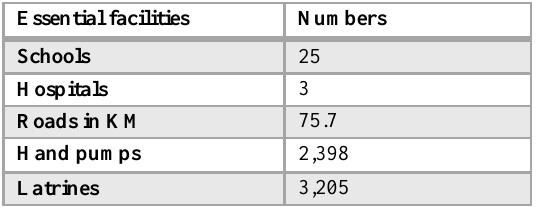
Table 1. Social and physical infrastructure in UC Agra Source: LSO Nangyal, UC Agra